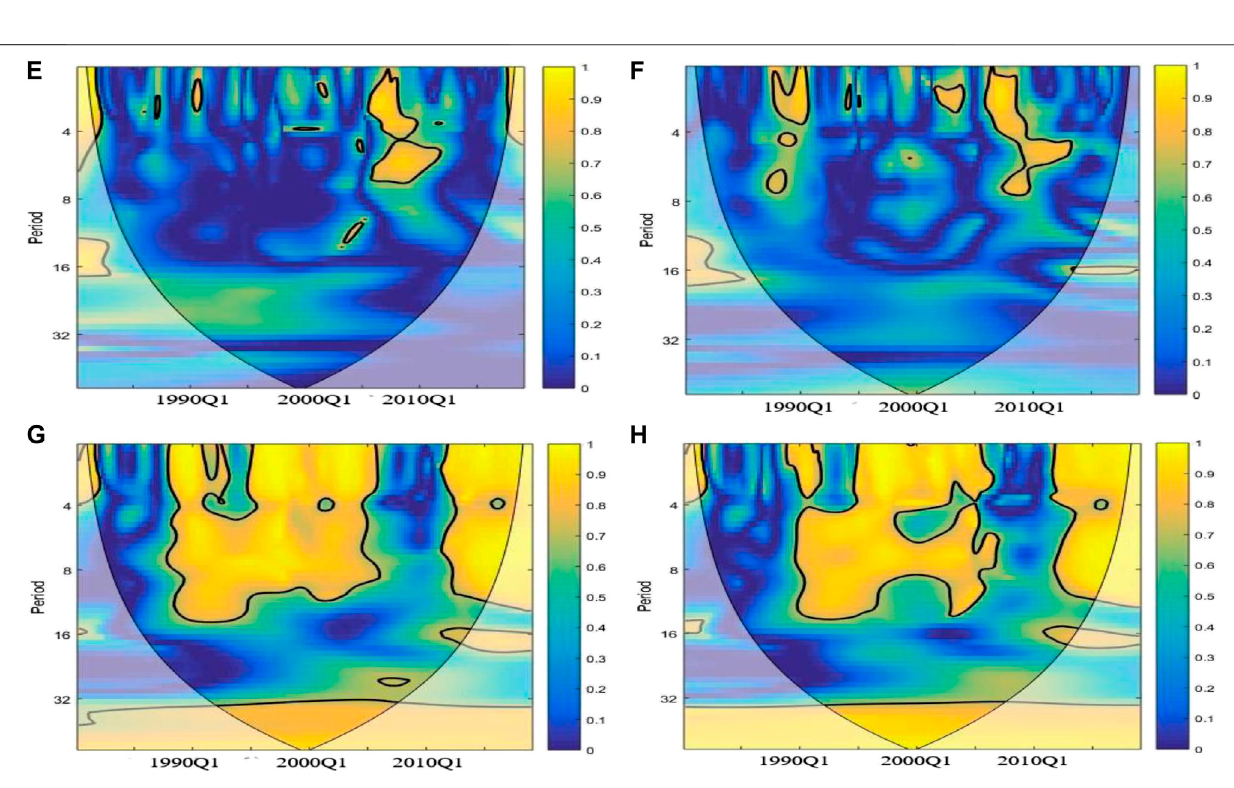
Frontiers in Environmental Science |